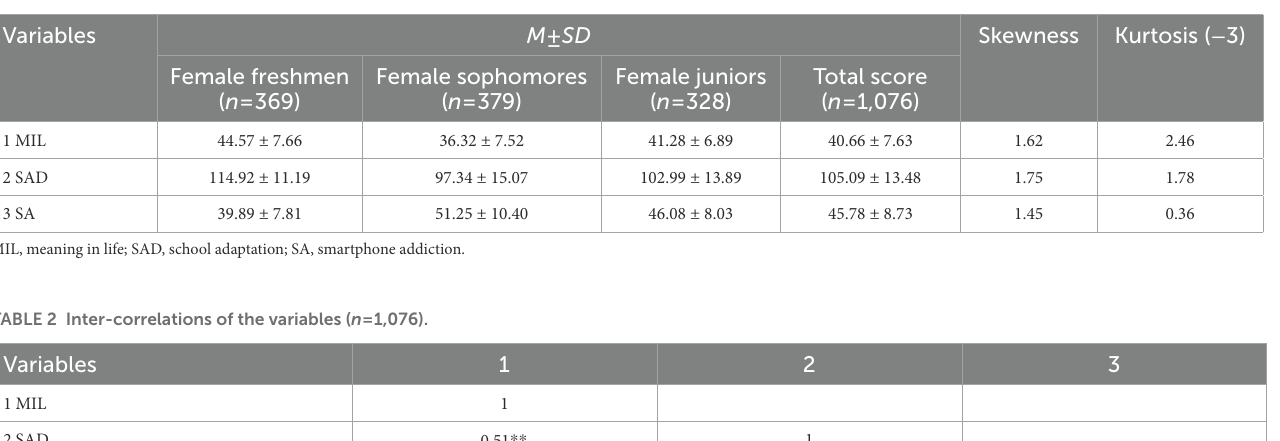
TABLE 1 Descriptive statistics of the variables ( n = 1,076).